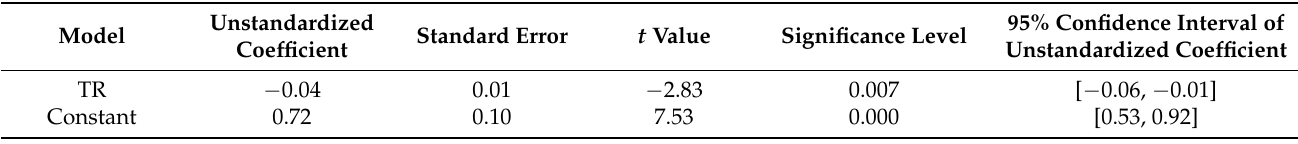
Table 2. The linear regression model of the temporary stability (TS, dependent variable) built by tree richness (TR, independent variable).